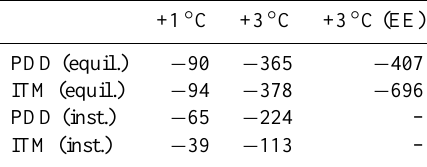
Table 3. Diagnosed equilibrium (equil.) and instantaneous (inst.) change in surface mass balance for the GIS from present day, under 1 ◦ C and 3 ◦ C of warming with present-day insolation and 3 ◦ C of warming with Eemian insolation (EE). All values are in Gt/a and are relative to a present day estimate of ca. 300 Gt/a (see Table